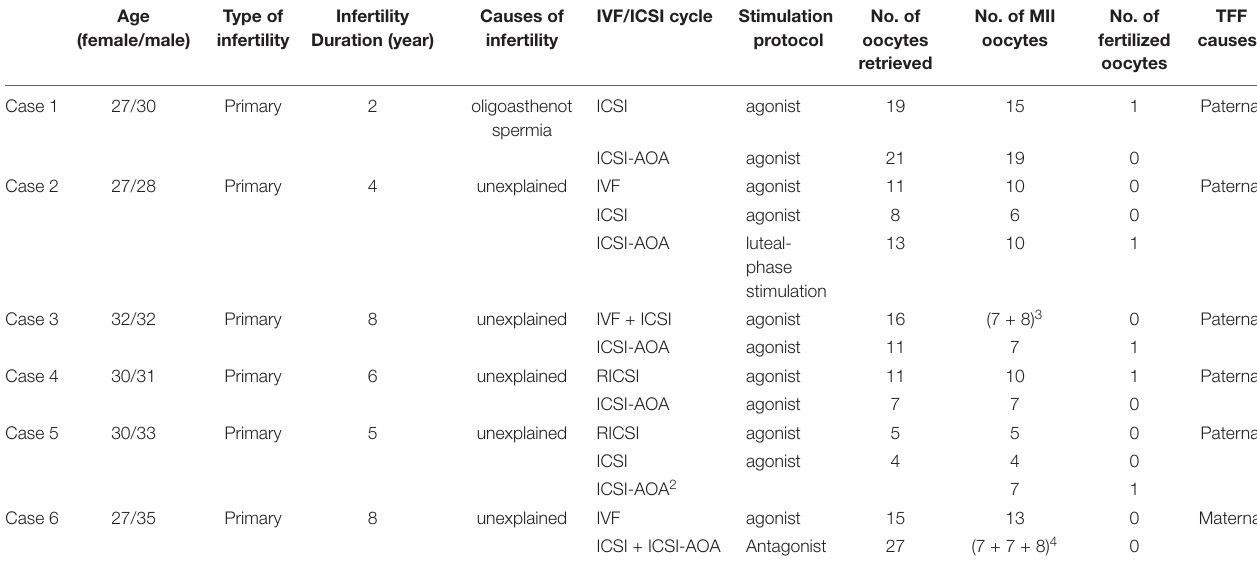
TABLE 1 | The clinical characteristics of the enrolled